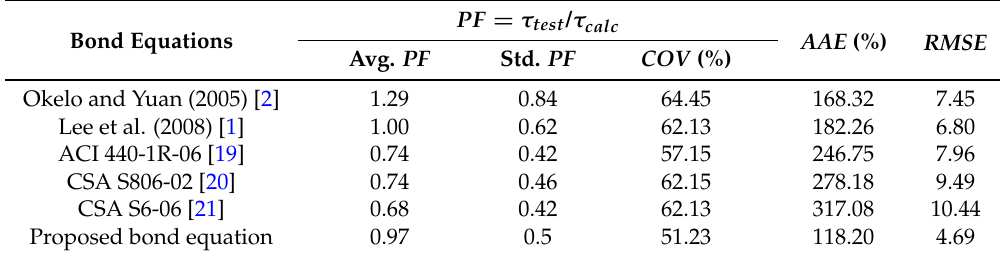
Table 5. Comparison of bond equations for the third group.